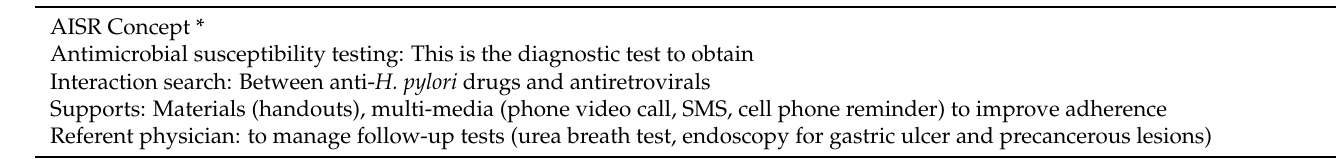
Table 3. To be remembered when diagnosing and treating H. pylori infection in people living with HIV receiving antiretrovirals.